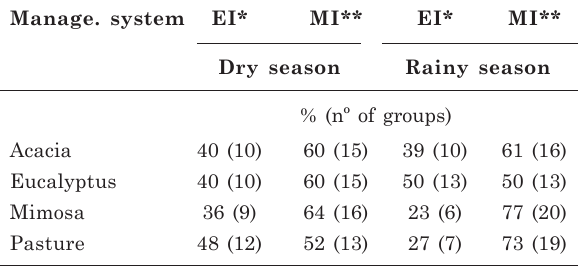
*EI - Extreme inhibition, **MI - Moderate inhibition (given as number of groups and percentage of groups per